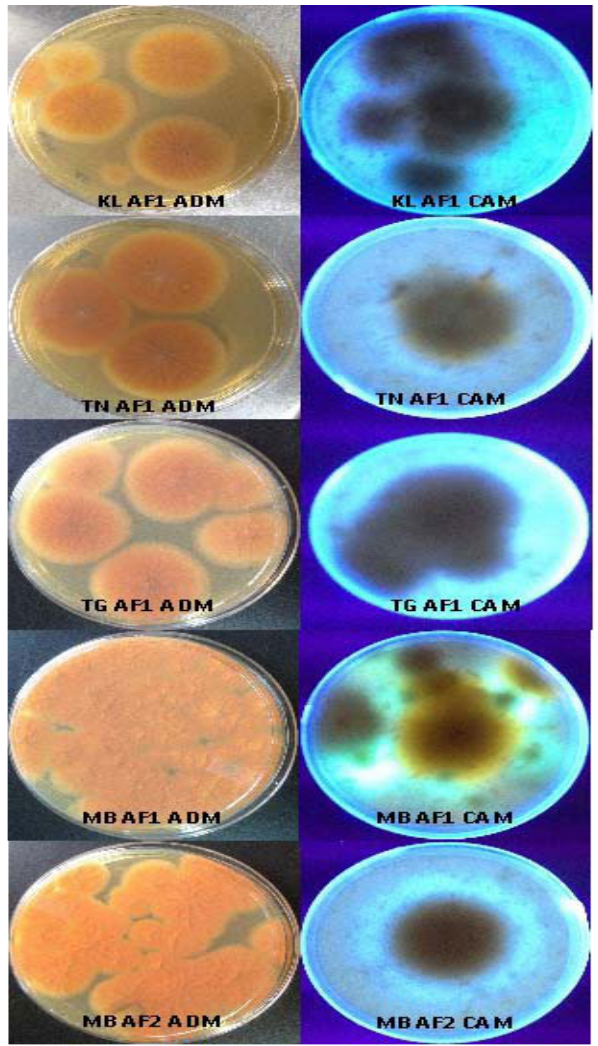
Fig. 6. Characteristic appearance of aflatoxigenic A. flavus on CAM and